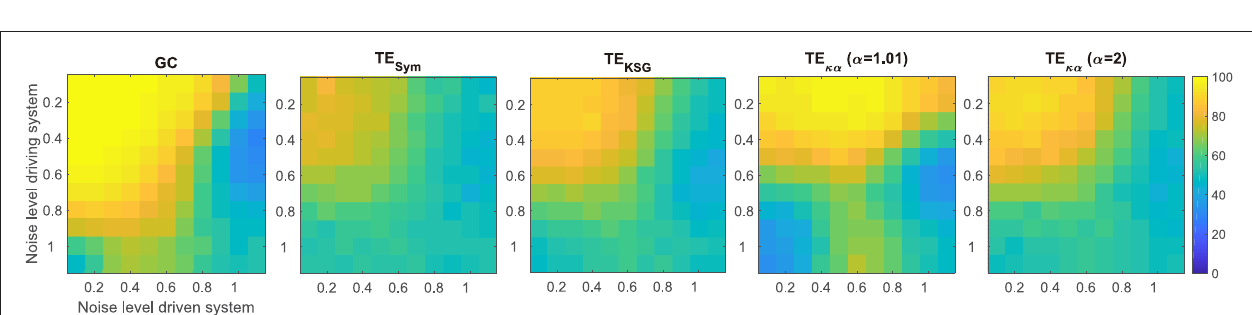
FIGURE 3 | Average accuracies in the detection of the preferred direction of information flow for synthetic data, generated from a unidirectional bivariate autoregressive model of order 3 under asymmetric noise level conditions. The vertical axis displays the noise level for the driving time series, while the horizontal axis does so for the driven time